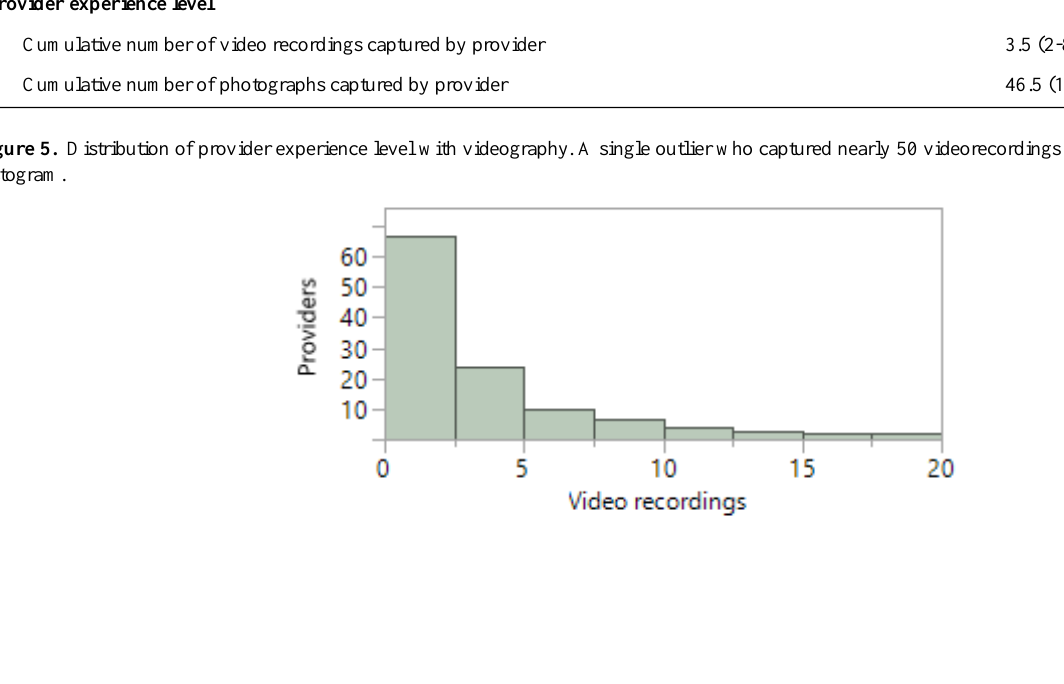
Extent of app use during encounter